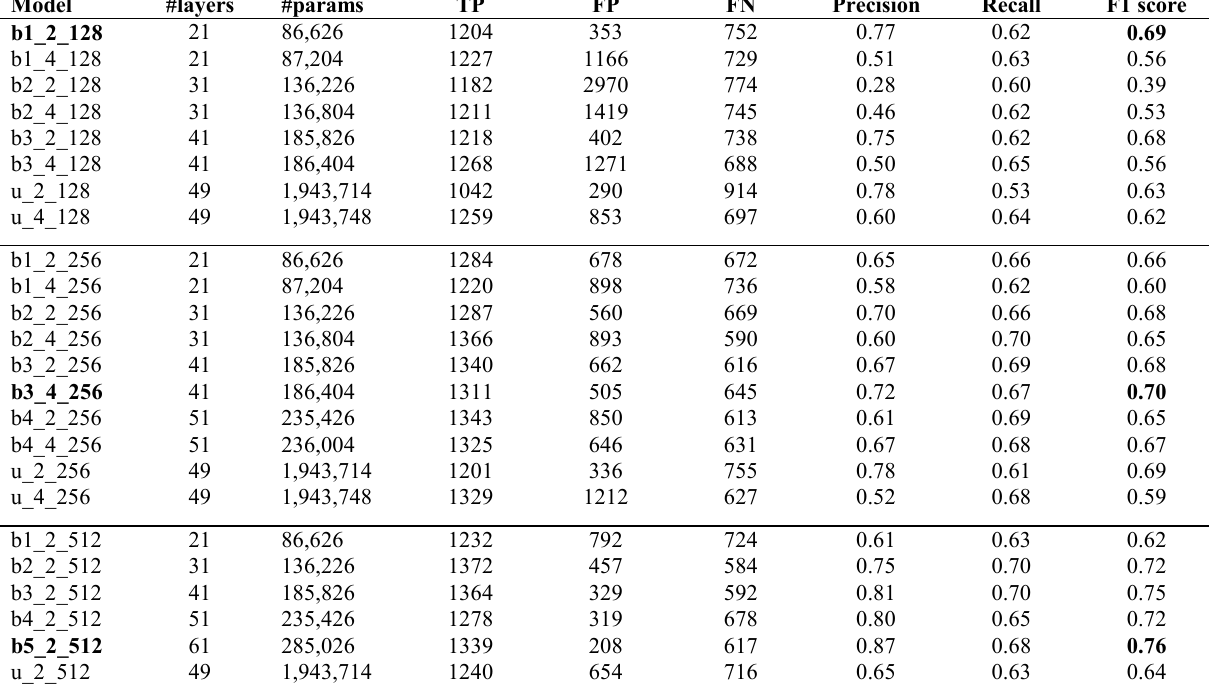
Table 1. Evaluation results. Models that have the name starting with the letter b are implemented to follow the design suggested in subsection 3.1. Model names are arranged in this way b{#blocks}_{#label channels}_{input shape}. Models that have the name starting with the letter u are implemented according to U-net proposed in (Ronneberger, 2015). Model names are arranged in